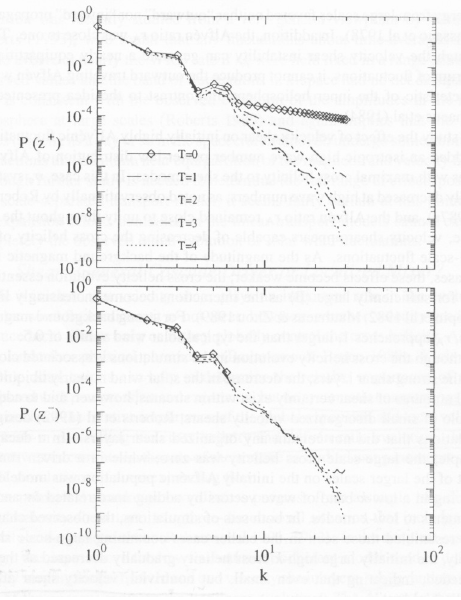
Figure 67: Time evolution of the power density spectra of 𝑧 + and 𝑧 − showing the turbulent evolution of the spectra due to velocity shear generation (from Roberts et al. ,